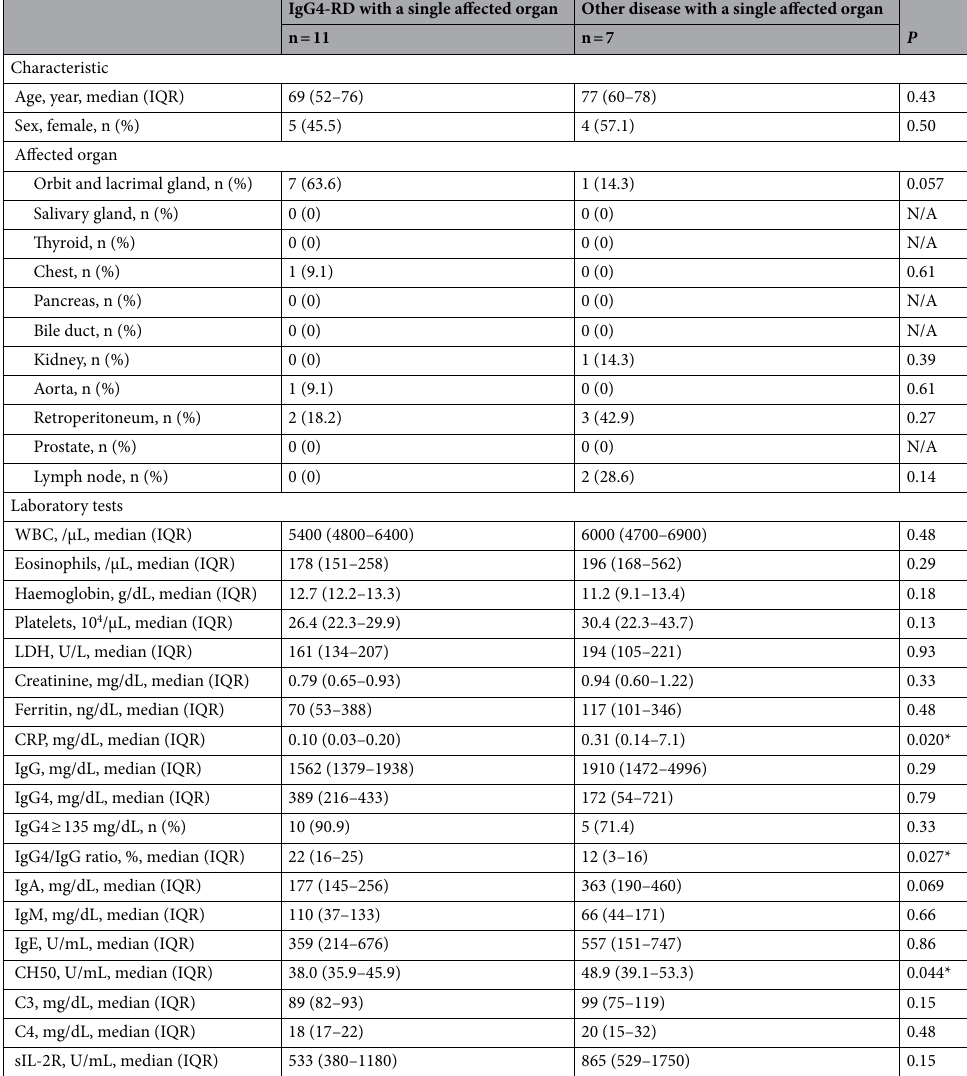
Table 2. Characteristics of patients with a single affected organ by IgG4-RD status. P values were determined using the Mann–Whitney U test or Fisher’s exact test, as appropriate. * P < 0.05. IgG4-RD immunoglobulin interleukin-2